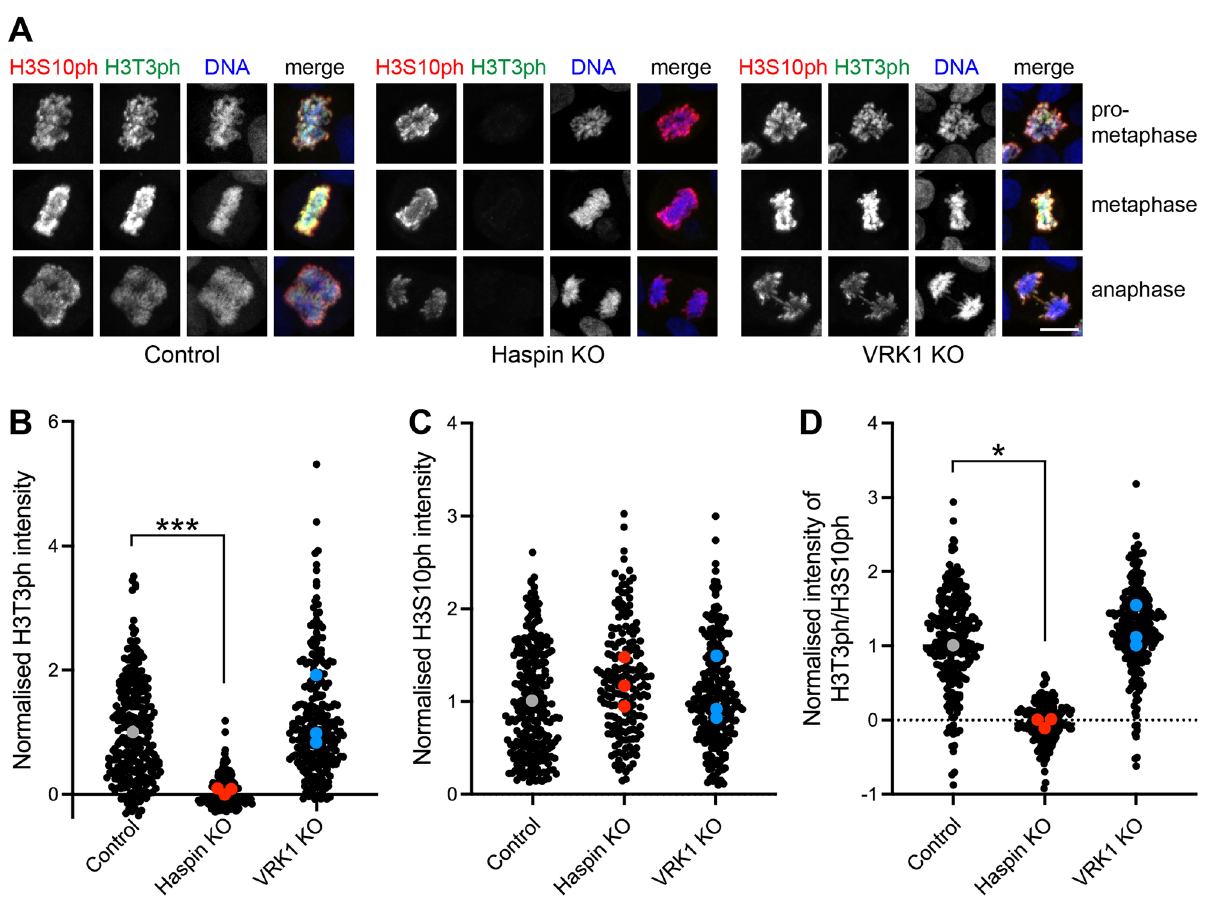
Figure 5. Immunofluorescence microscopy of histone H3 phosphorylation in HAP1 cells. ( A ) Loss of Haspin, but not VRK1, eliminates H3T3ph in individual mitotic HAP1 cells, as detected by immunofluorescence microscopy. H3S10ph appears unaffected in both cases. Scale bar, 10 µm. ( B ) Quantification of the intensity of H3T3ph staining in cells stained as in ( A ). Black symbols represent individual cells. Grey, red and blue symbols show the average values for each of 3 independent experiments, normalised to control HAP1 cells. ***p = 0.0019 (two-tailed t test using non-normalised data; n = 3). ( C ) Quantification of the intensity of H3S10ph staining in cells as in ( B ). Two-tailed t tests using non-normalised data revealed no significant differences at p = 0.05 (n = 3). ( D ) Quantification of the ratio of H3T3ph intensity to H3S10ph intensity in cells as in ( B ). *p = 0.0496 (two- tailed t test using non-normalised data; n =